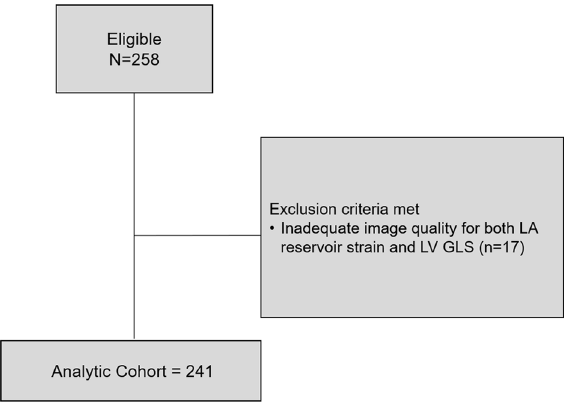
Figure 1. STROBE flow diagram for study